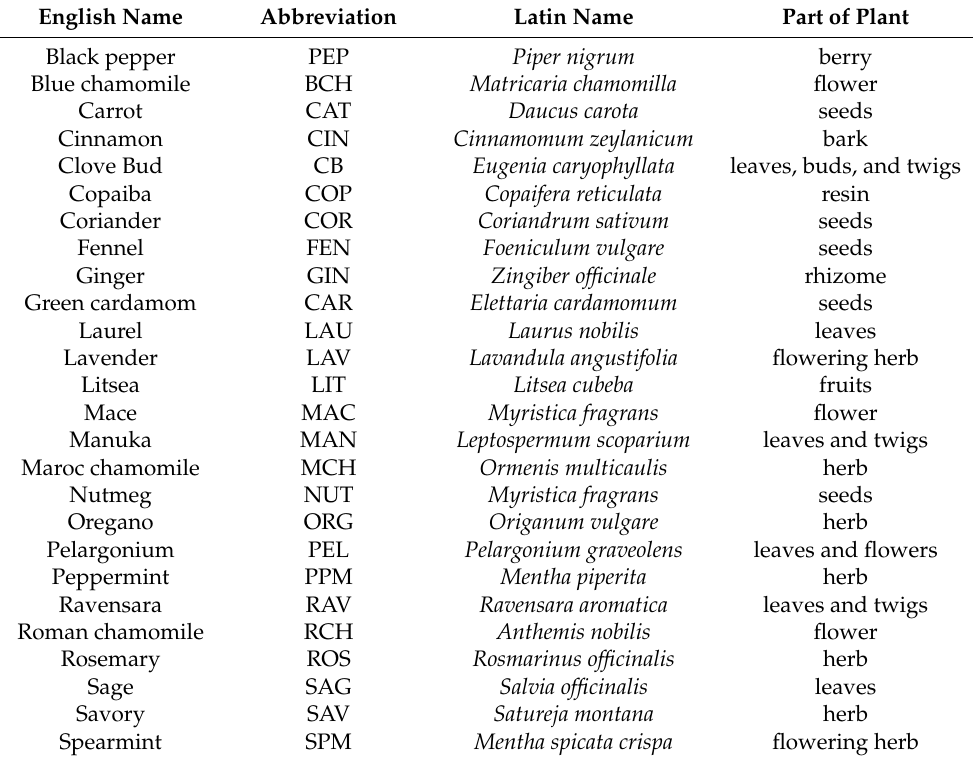
Table 1. The list of essential oils, abbreviations, Latin names, and part of the used